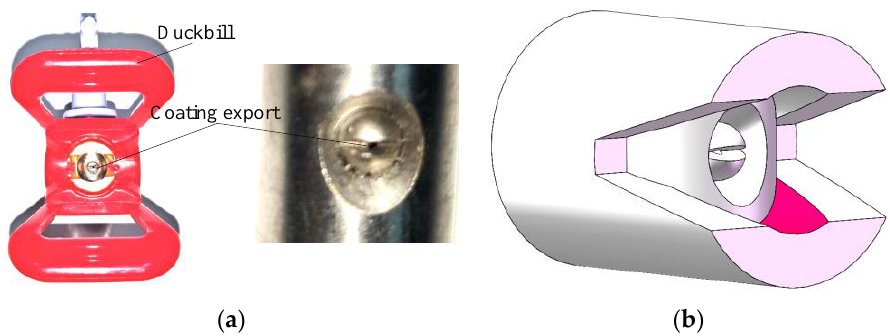
Figure 2. Nozzle geometric model. ( a ) Picture of the nozzle. ( b ) Nozzle model.